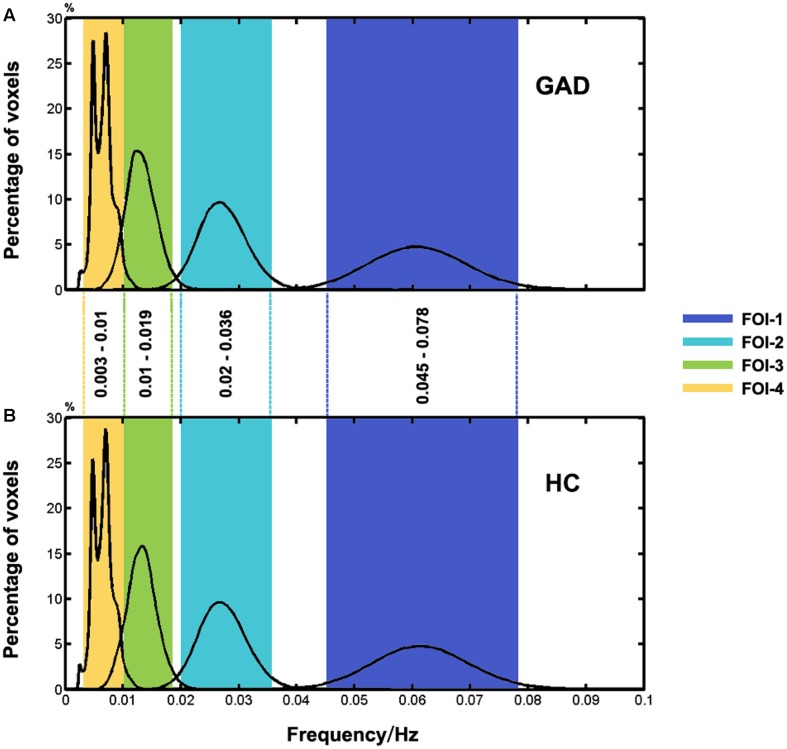
Histogram of frequency distribution between two groups. The histograms of the HWF distributions show the first four intrinsic mode functions (IMFs) of each voxel in the whole-brain gray matter across all participants in each group by using the CEEMDAN approach. Each of the sub-histograms in corresponding IMFs displays amount of the whole-brain gray matter voxels within the GAD (A) and HC (B) group, respectively. Vertical axis represents the percentage of the number of voxels with HWF equal to the frequency on the horizontal axis in the whole-brain gray matter. The rectangular bar with different colors represents the frequency bands of the final selected FOIs. Colors assigned in the sequence of blue, cyan, green, and yellow represent FOI-1 (0.045–0.078 Hz), FOI-2 (0.02–0.036Hz), FOI-3 (0.01–0.019 Hz), and FOI-4 (0.003–0.01 Hz), respectively.